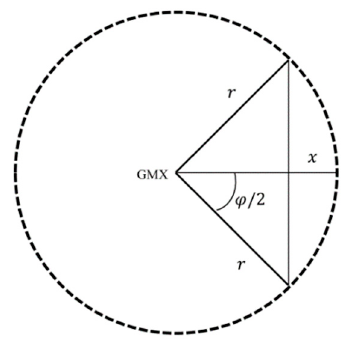
Figure 5. Diagram illustrating the calculation of the chord height (x) formed by two profiles of maximum crown radius (r) separated by the angular spacing ( φ ).